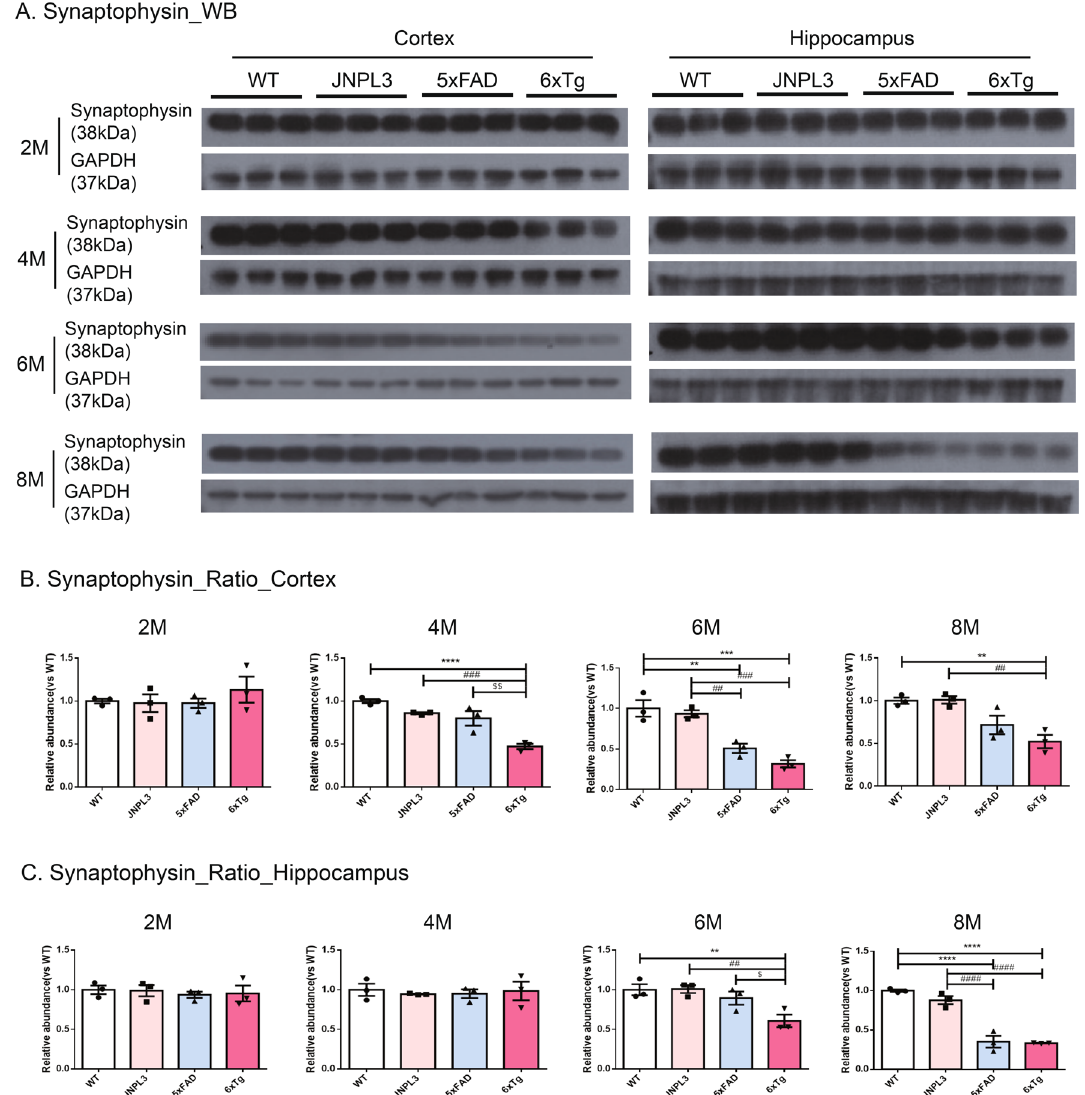
Figure 5. Synaptophysin levels in the cortical and hippocampal area of 6xTg mice brains. Presynaptic receptor proteins (Synaptophysin, 38 kDa) were detected in cortical and hippocampal brain lysates of 2-, 4-, 6-, and 8-month-old WT, JNPL3, 5xFAD, and 6xTg mice by Western blot analysis. ( A ) Representative Western blots of synaptophysin from cortical and hippocampal brain lysates were shown. In Fig. S5, full-length blots were presented. ( B , C ) The graph shows the percentage of the density of synaptophysin normalized to GAPDH on Western blot bands from cortical and hippocampal tissue lysates. ( B ) In the cortex, 4-, 6- and 8-month- old 6xTg mice showed significantly decreased synaptophysin compared with 5xFAD and WT mice. ( C ) In the hippocampus, 6- and 8-month-old 6xTg mice showed significantly decreased synaptophysin compared with 5xFAD and WT mice. All data are shown as means ± SEM, and each experiment was repeated five times (n = 3 per group). Statistical analyses were performed by one-way ANOVA followed by the Tukey’s multiple comparisons test. **** p < 0.0001, *** p < 0.001, ** p < 0.01 vs. WT; #### p < 0.0001, ### p < 0.001, ## p < 0.01, # p < 0.05 vs. JNPL3; $$ p < 0.01, $ p < 0.05 vs. (cortex, 33.67 ± 4.91; hippocampus, 20.00 ± 3.79 at 4 months), but no MHC Class II staining was seen in WT & JNPL3 mice (Fig. S7B&D). Neuronal and synaptic loss in 6xTg mice. From the findings, it seems that the age-dependent forma- tion of the neuritic plaque and tau deposition induced synaptic reduction and neuronal loss. To determine the loss of synapse number on the integrity of synapses, we examined the levels of synaptophysin proteins (Fig. 5A). At 2 months of age, there was no significant difference in the synaptophysin amount in the cortex and hippocam- pus among WT, 5xFAD, and 6xTg mice. In the cortex of 5xFAD mice a significant decrease of synaptophysin levels was shown from 6 months of age compared to WT and JNPL3 mice (5xFAD ratio vs WT; 0.67 ± 0.04, p < 0.01 vs. WT, p < 0.05 vs. JNPL3) (Fig. 5B). At 8 months of age, the amount of synaptophysin content was